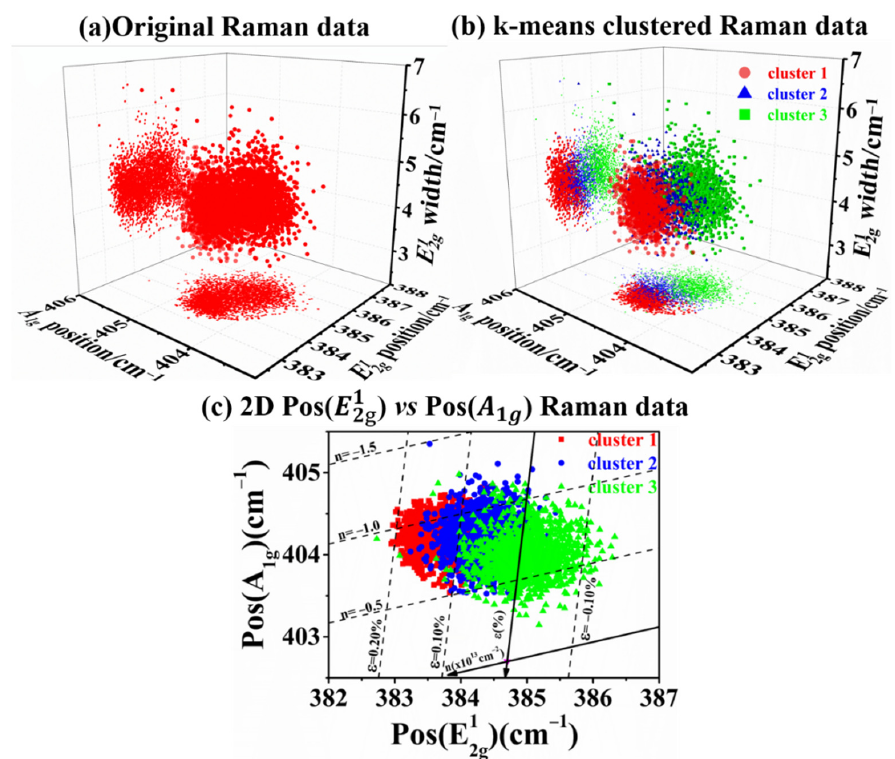
Figure 3. Correlative analysis for Raman spectral features to quantitatively evaluate the inhomoge- neity on monolayer MoS 2 . ( a , b ) are the 3D correlative graph of peak position (Pos( 𝐸 (cid:2870)(cid:3034)(cid:2869) ) and Pos( 𝐴 (cid:2869)(cid:3034) )) and peak width ( 𝐸 (cid:2870)(cid:3034)(cid:2869) ) with the original and k-means clustered Raman data, respectively. ( c ) The 2D correlative analysis of Pos( 𝐸 (cid:2870)(cid:3034)(cid:2869) ) and Pos( 𝐴 (cid:2869)(cid:3034) ) to accurately extract the contributions of strain and doping effects in cluster 1–3 with red, blue, and green labels.